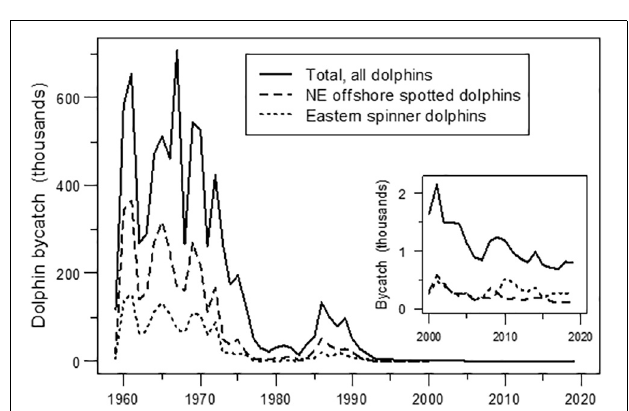
FIGURE 2 | Estimated number of dolphins killed annually in the eastern tropical Pacific tuna purse-seine fishery, total for all dolphins and separately for the stocks of the two dolphin species with the highest number killed (Wade et al., 2007; Inter-American Tropical Tuna Commission [IATTC], 2020). The inset graph has an expanded vertical scale to show details from 2000 to 2019; notice the change of scale on the Y